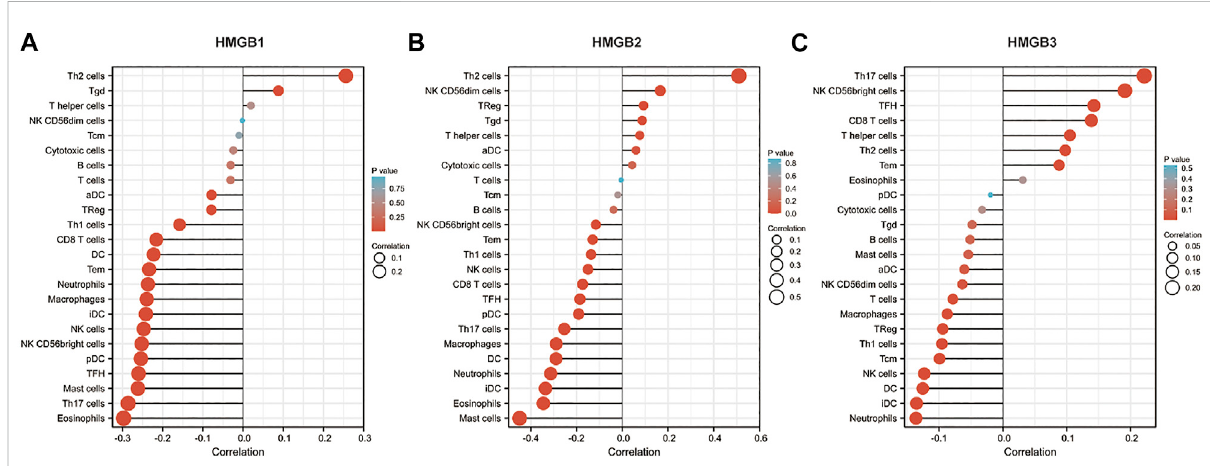
FIGURE 6 Correlation of HMGB familymembers gene expressionwith levels of immune in fi ltration in NSCLC. Tcm, central memory Tcells; Tem, effector memory T cells; TFH, T follicular helper cells; Tgd, gamma delta T cells; Treg, T regulatory cells.